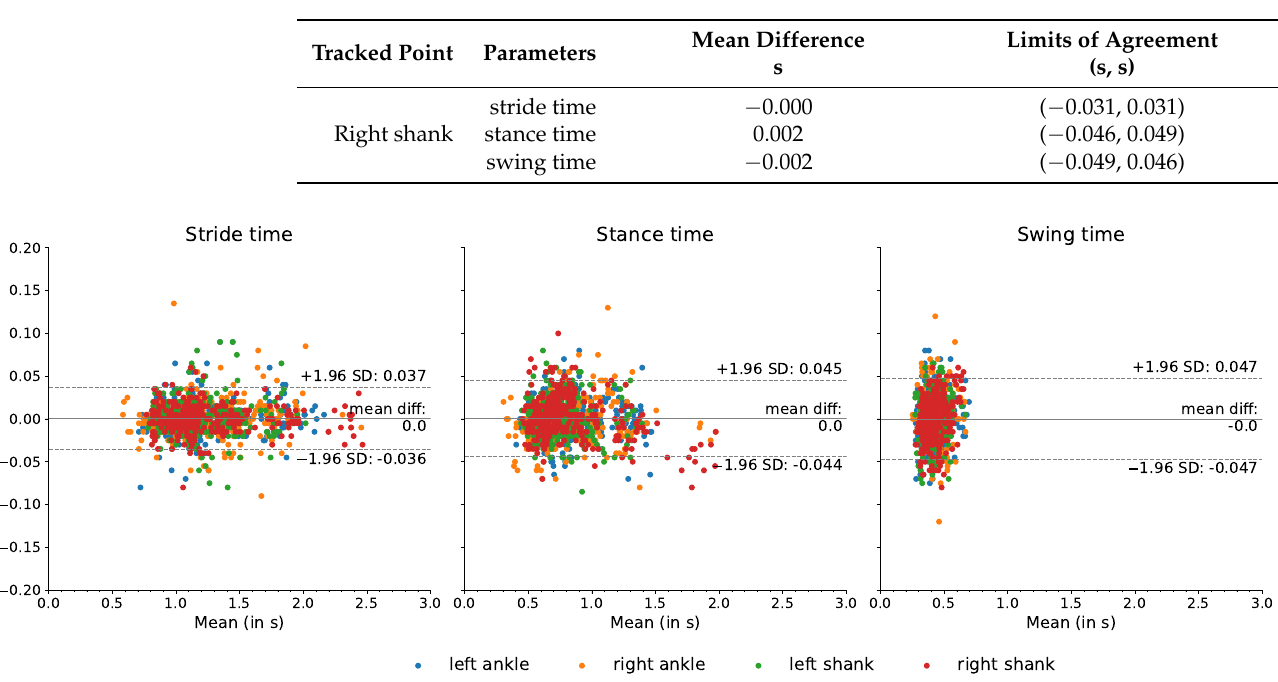
Figure 4. The agreement of extracted gait parameters between the sensor-based and marker-based methods. The differences between the stride-specific temporal gait parameters extracted from the marker-based and proposed approach are plotted against the